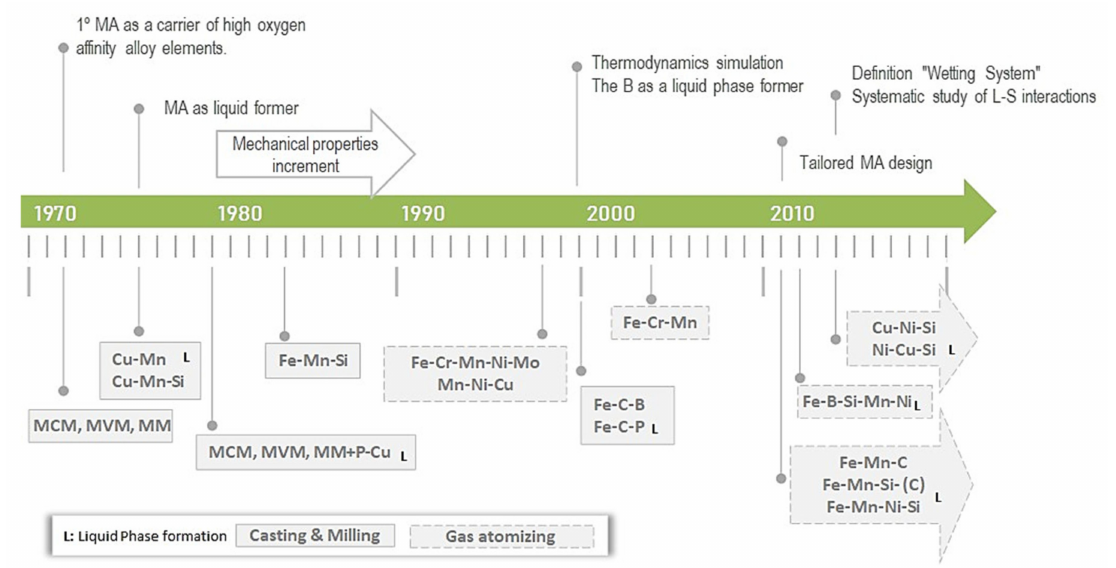
Figure 2. Evolution of the research paths in master alloys (MA) for sintered steels. The evolution has been monitored according to the pursuit of the objectives: (i) the introduction of elements with high affinity for the oxygen and/or (ii) the formation of a liquid